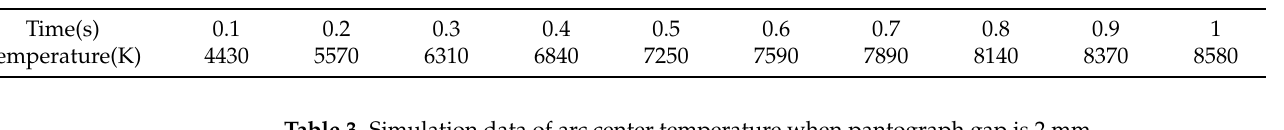
Table 3. Simulation data of arc center temperature when pantograph gap is 2 mm.